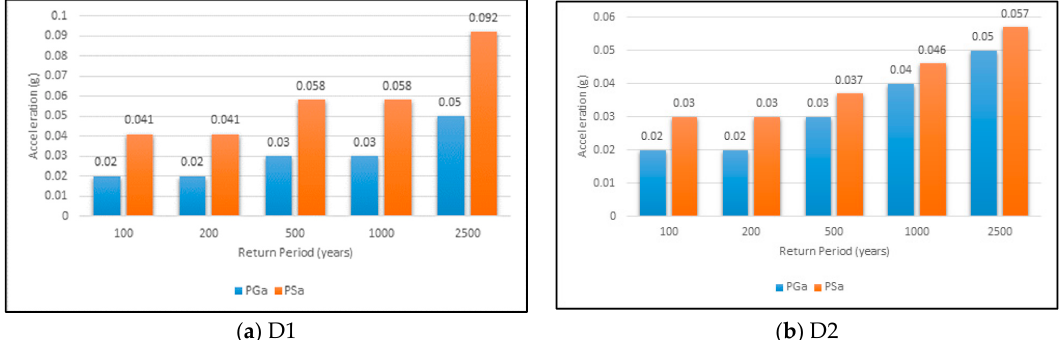
Figure 7. PGa and PSa for D1 and D2 under far-field seismic events.